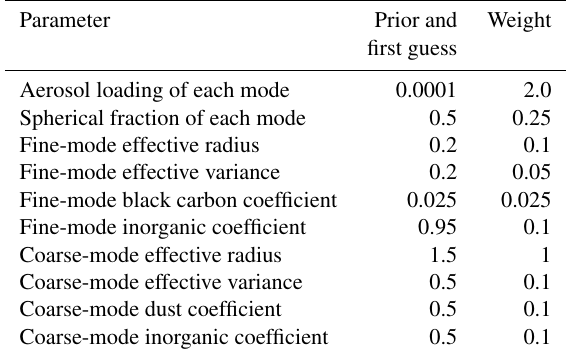
Table 2. Prior and first guess and weight for each parameter in the synthetic